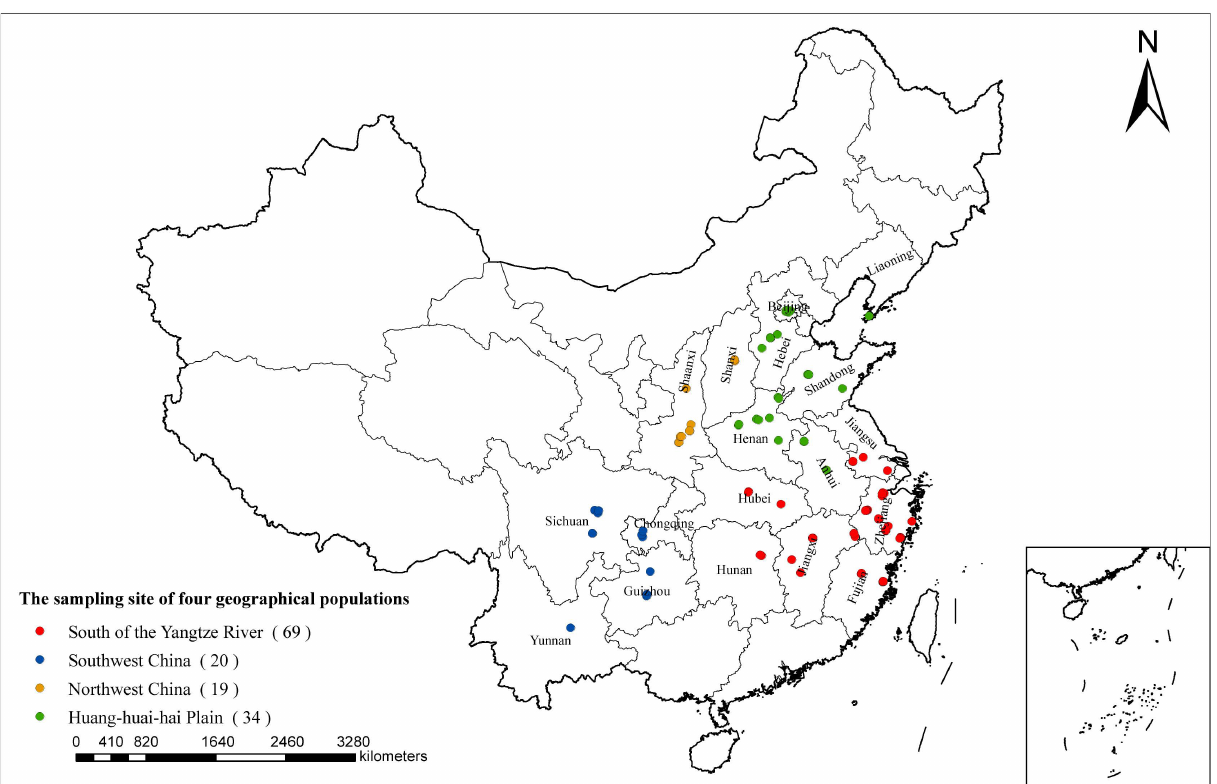
Figure 1. Geographical distribution of the 142 PaWB phytoplasma strains from four geographi- cal populations, south of the Yangtze River population (69 strains), southwest China population (20 strains), northwest China population (19 strains), Huang-huai-hai Plain population (34